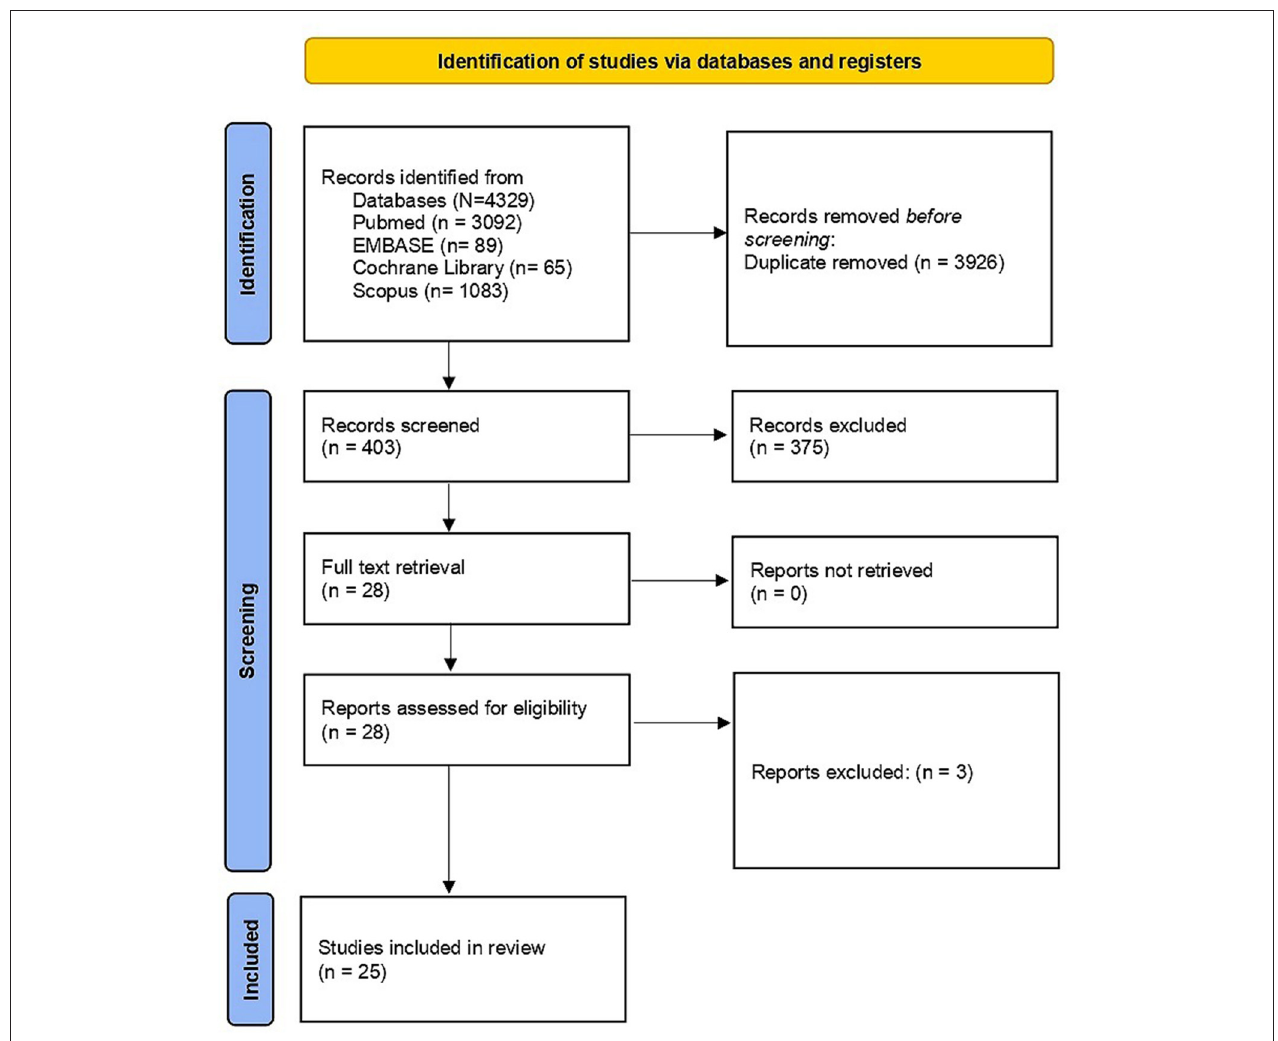
FIGURE 1 | PRISMA flow diagram on selection process. From: Page et al. (24). For more information, visit: